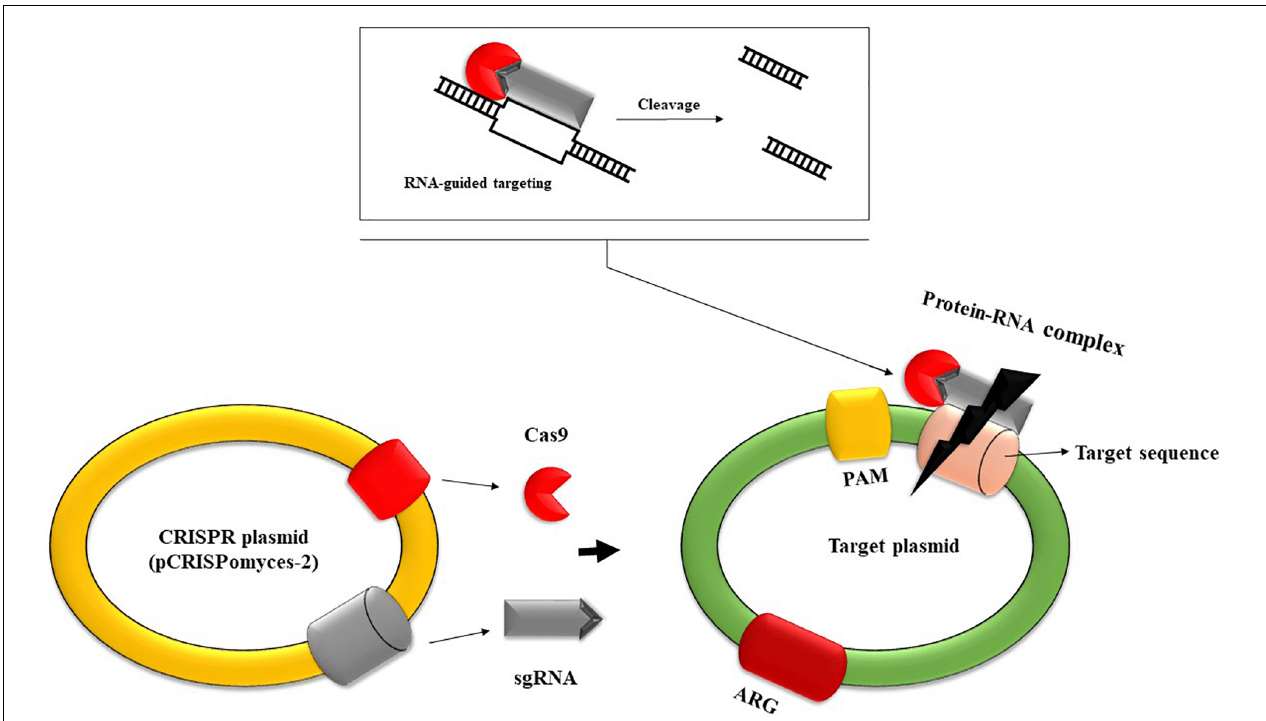
FIGURE 3 | Schematic representation of CRISPR-based plasmid system capable of removing MGE-like resistance plasmids. This system contains two sgRNA transcripts, the cas9 nuclease, and other structural elements. Firstly, sgRNA forms a complex with cas nuclease. The sgRNA transcripts guide cas9 nuclease to introduce double-stranded breaks at the ends of the target DNA, leading to cleavage. Direct target recognition is achieved through recognition of protospacer adjacent motifs (PAM), short DNA sequences that are not found in CRISPR loci, so there is no risk of self-degradation (So et al., 2017). Subsequently, the gap is filled through homologous recombination by an editing template. This system can be used to edit the genome of several antibiotic-resistant bacterial strains, leading to the removal of resistance